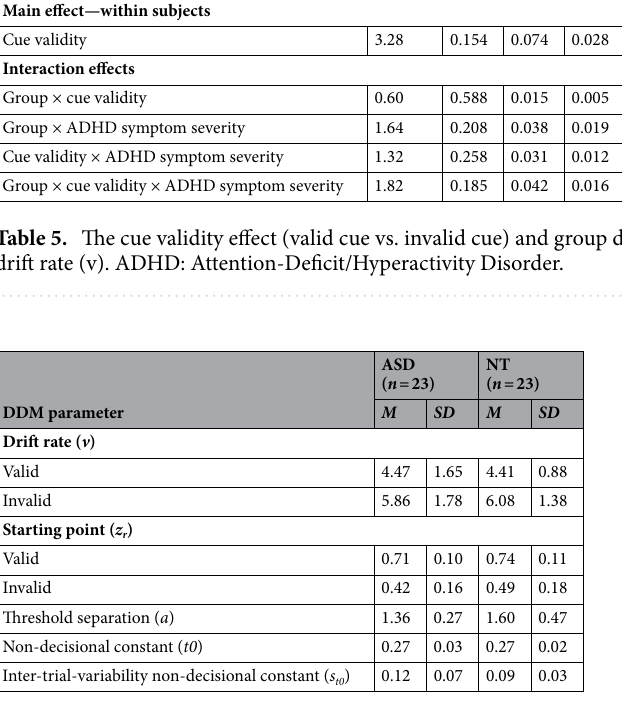
Table 6. Descriptive summary of estimated Diffusion Drift Model parameters in ASD and NT. DDM: diffusion drift model; ASD: Autism Spectrum Disorder; NT: